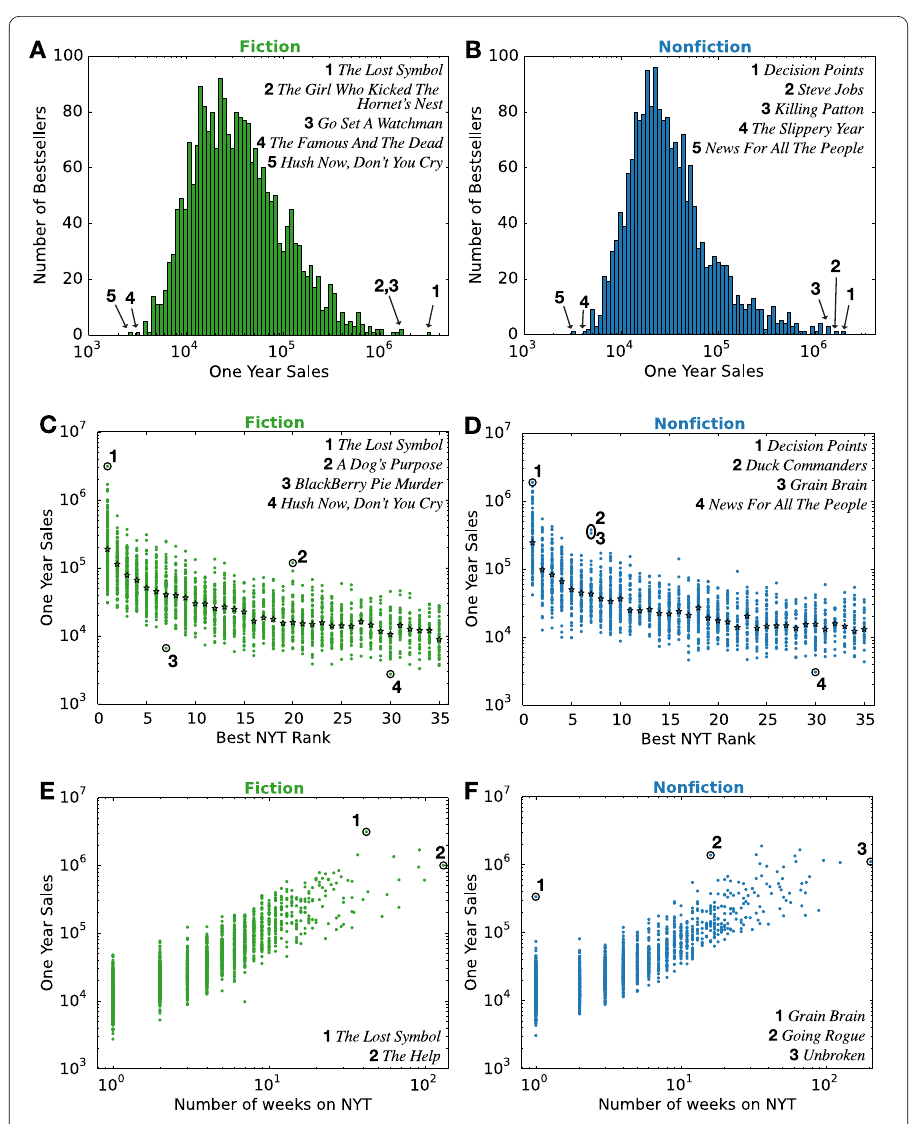
Figure 3 ComparisonoftheNYTBLstatisticsandfirstyearsales . The distribution of the number of copies sold in a year for all hardcover bestsellers in ( A ) fiction and ( B ) nonfiction. The relation between one year sales and the best rank of the book in NYTBL ( C ) for fiction and ( D ) for nonfiction. The relation between one year sales and the length of stay on NYTBL ( E ) for fiction and ( F ) for nonfiction. Most hardcover bestsellers sell between 10,000 and 100,000 copies in their first year for both fiction and nonfiction, and the higher they get in the list and the longer they stay on, the more copies they sell in a